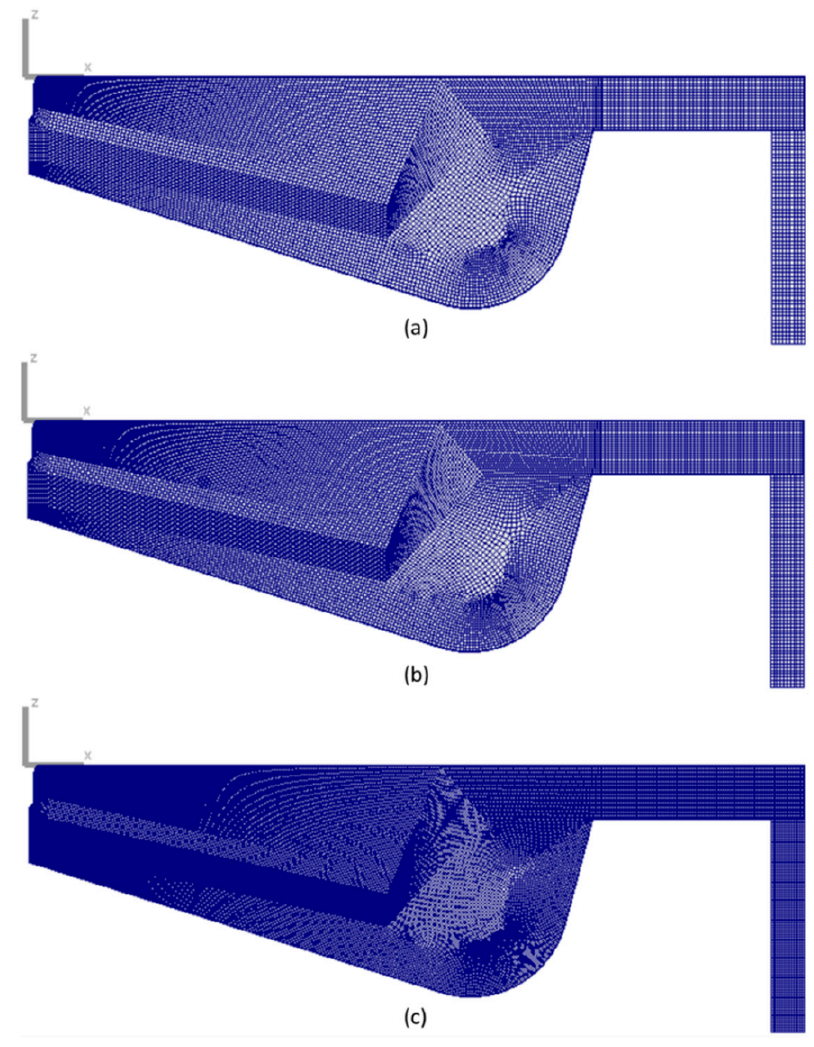
Figure 5. The computational coarse ( a ), medium ( b ), and fine ( c ) mesh resolutions at the